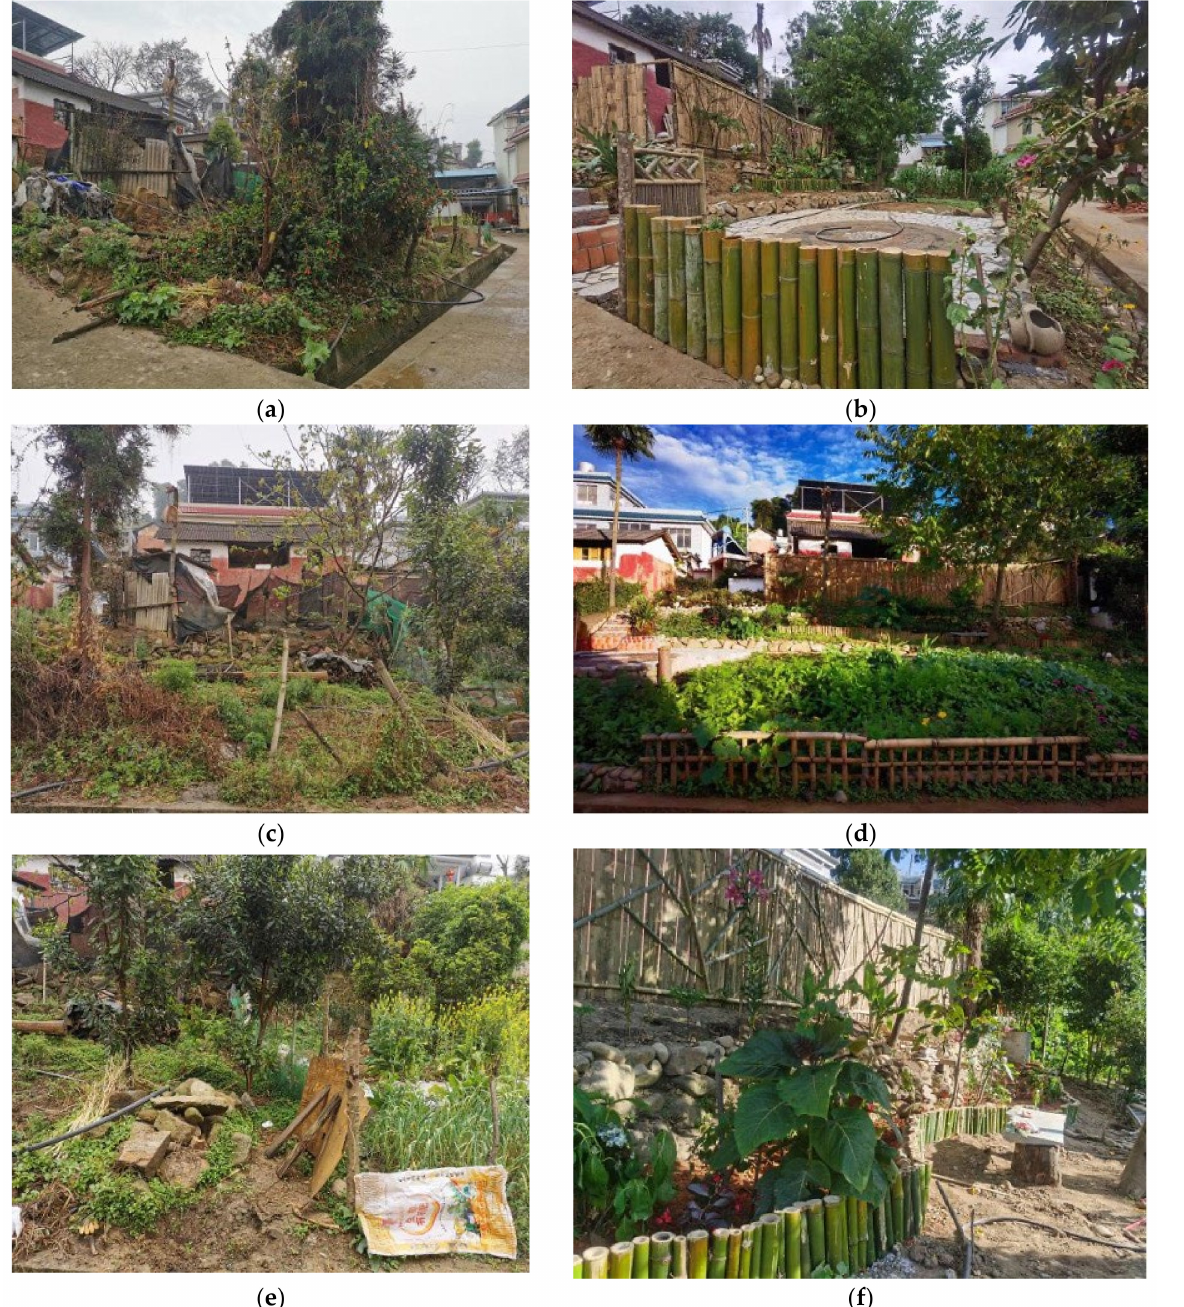
Figure 9. Planners working with local villagers on rebuilding their farmyards in front of their houses and behind. ( a ) The farmyard entrance before rebuilding; ( b ) the farmyard entrance after rebuilding; ( c ) the grounds and fences before rebuilding; ( d ) the grounds and fences after rebuilding ( e ) the vegetation before rebuilding; ( f ) and the vegetation after rebuilding. Source: the authors, taken in August